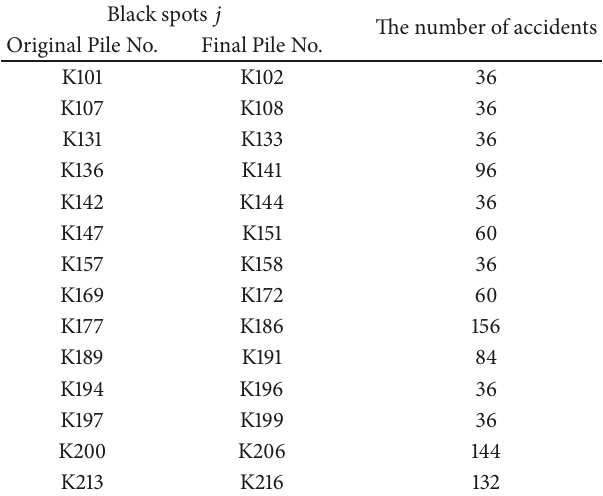
The number of accidents